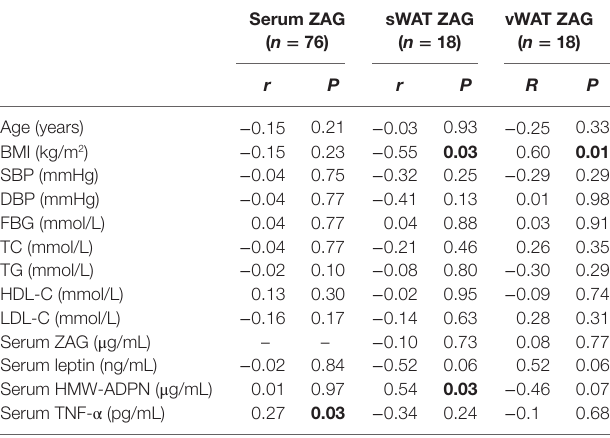
TaBle 2 | Partial correlation analysis between ZAG levels in both serum and WAT and clinical parameters in CRC